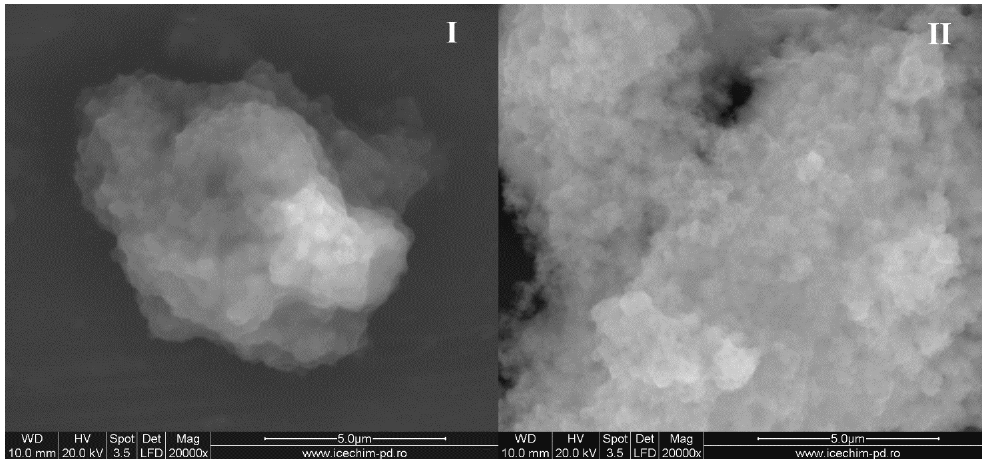
Figure 3. Scanning electron microscopy (SEM) pictures of the samples obtained at ( I ) 1.5/1 (sample No.5) and ( II ) 3/1 OLA/Na (sample No.7).